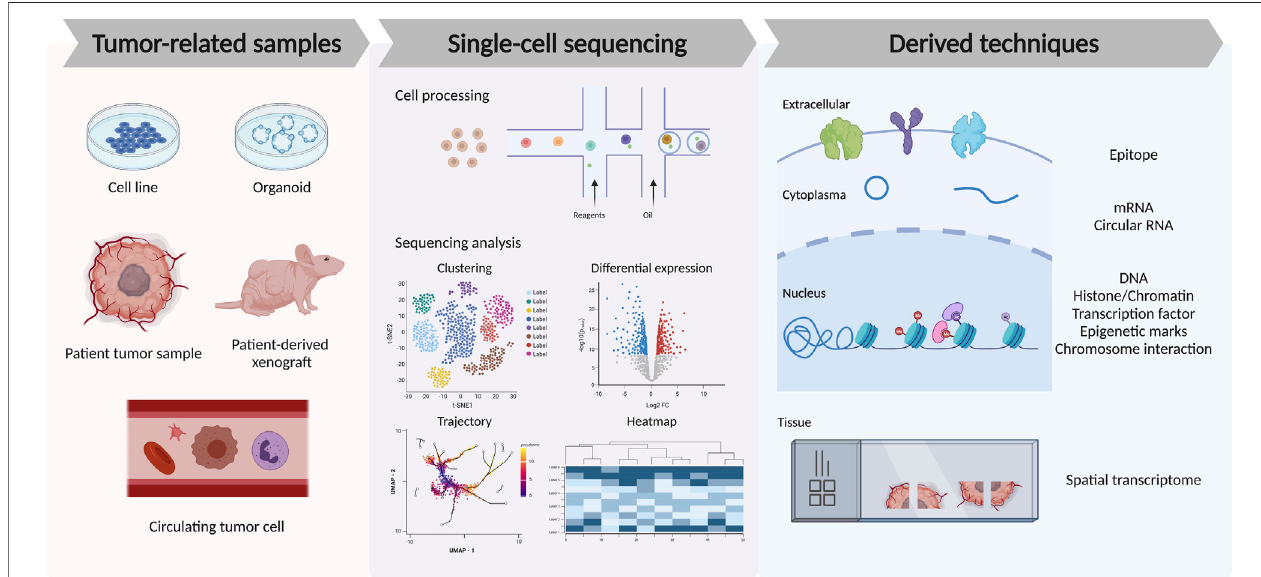
FIGURE 2 | Recent advances in single-cell technologies to analyze tumor microenvironment. The left panel shows different tumor-related sample types used for single-cell TME studies. The middle panel shows the cell process of droplet-based single-cell sequencing technology and the downstream analysis from sequencing data, including the clustering and cell-type annotation, differential gene expression among samples or cell types, trajectory analysis of the cell lineage, and heatmap for gene dynamics. The right panel shows the recent derived techniques from single-cell sequencing, which allows the detection of the single-cell epitope, mRNA, circular RNA, DNA, epigenetic modi fi cation, chromosome interaction, and spatial information among the tissue.